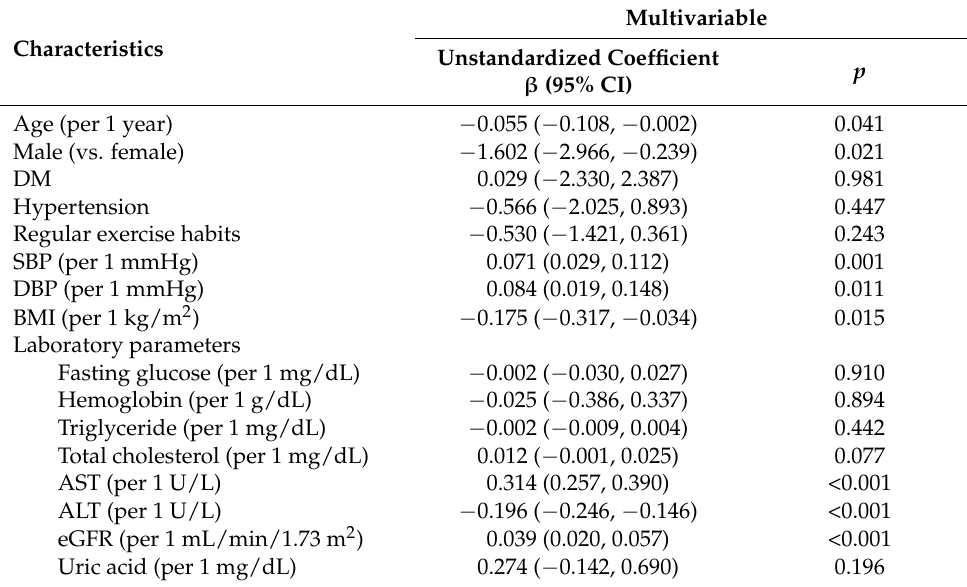
Table 2. Determinants for (cid:52) FEV1/FVC using multivariable linear regression